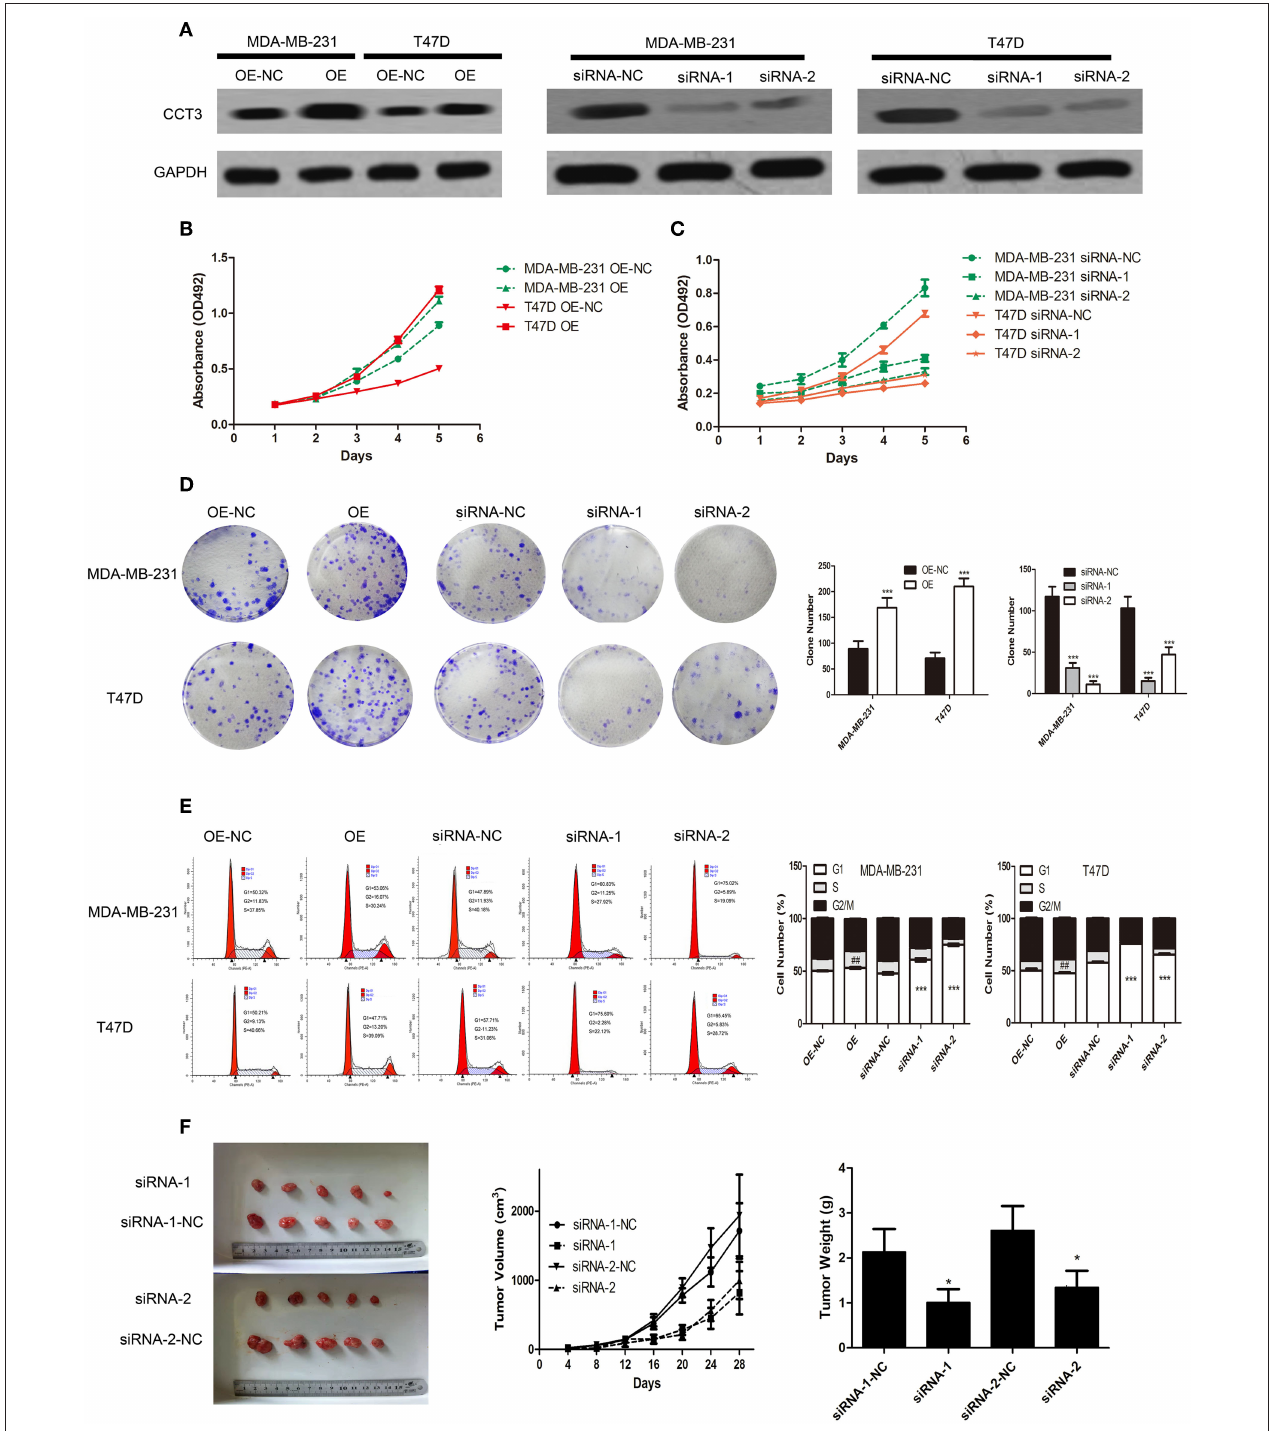
FIGURE 2 | CCT-3 promotes breast cancer cell proliferation and tumorigenicity in vitro and in vivo. (A) Protein levels of CCT-3 expression in CCT-3-overexpressed and CCT-3-silenced cells. MTT assays (B,C) , colony formation assay (D) , and flow cytometric analysis (E) indicated that the growth rates increased in CCT-3-overexpressed cells and decreased in CCT-3-silenced cells. The cells were arrested in G2/M phase when CCT-3-silenced. Values are mean ± SD of three independent experiments. ## p < 0.01 (OE vs. OE-NC), *** p < 0.001 (siRNA vs. siRNA-NC), t -test. (F) Tumors derived from the vector-infected and the CCT-3-silenced cells. Representative images of tumor growth (left). Tumor volume growth curves (middle). Mean tumor weight (right) at 28 days after inoculation. * p < 0.05, t -test.